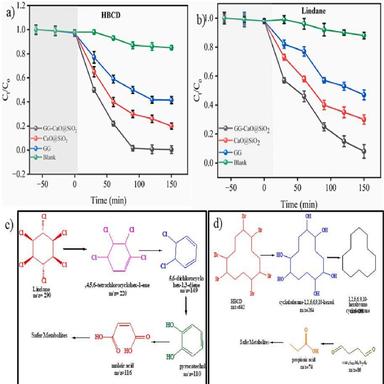
(a–b) Chemical kinetics study of HBCD and Lindane at optimised parameter (c–d) Proposed degradation pathway for the degradation of Lindane and HBCD.